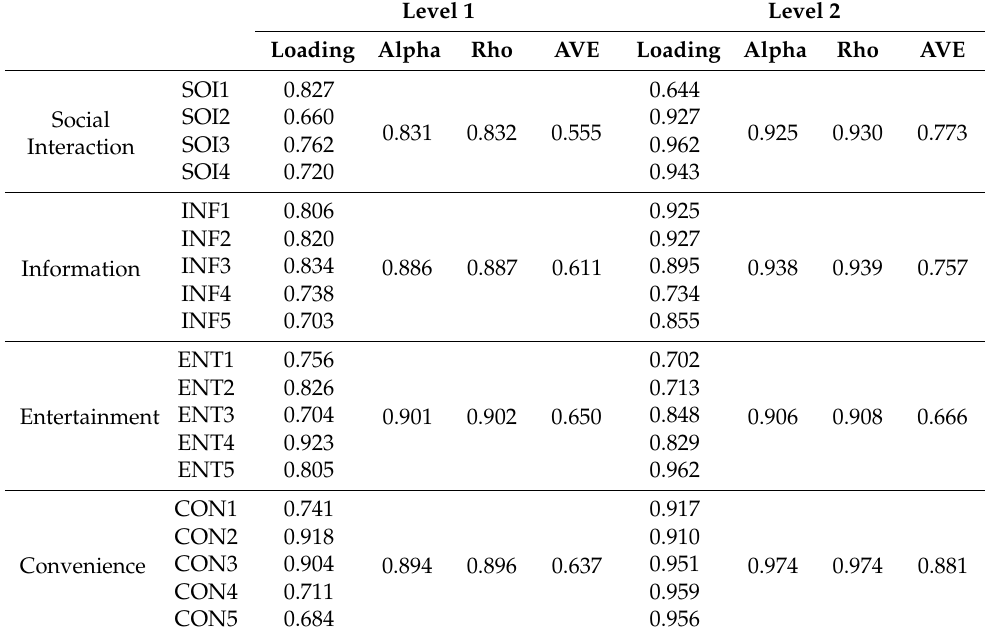
Table 3. Factor Loadings, Reliability Coefficients and AVEs of Modified Multilevel